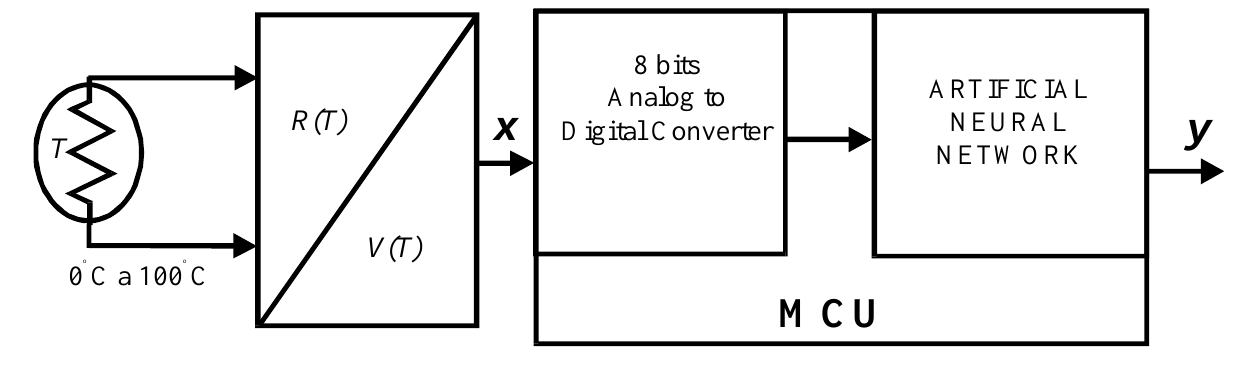
Figure 4. Structure of temperature measurement